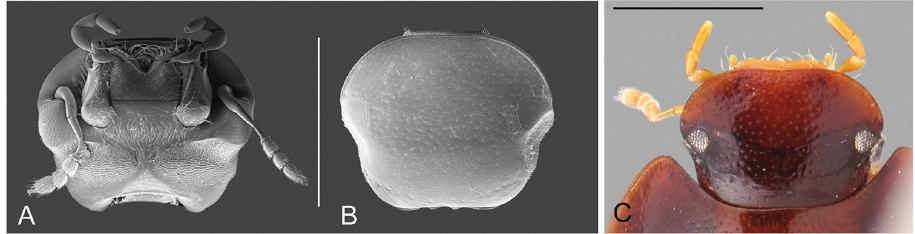
Figure 4. Head of Q. reticulatus : A SEM ventral view B SEM dorsal view C dorsal view. Scale bar: 0.5 mm.